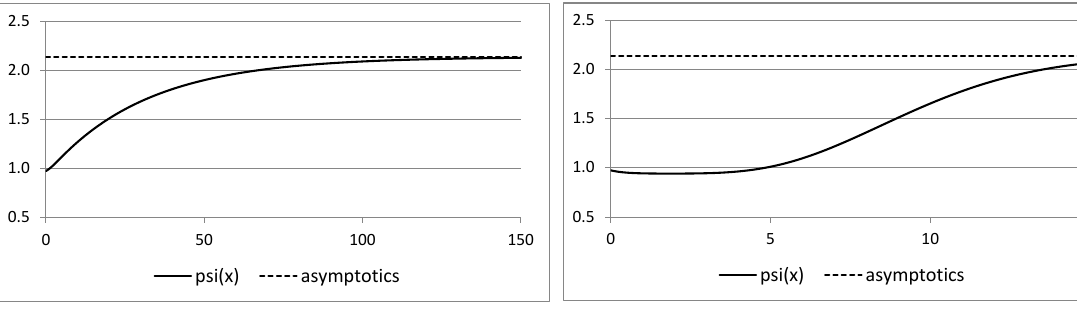
= 6% and ε = 5% : lhs: exponential CoC